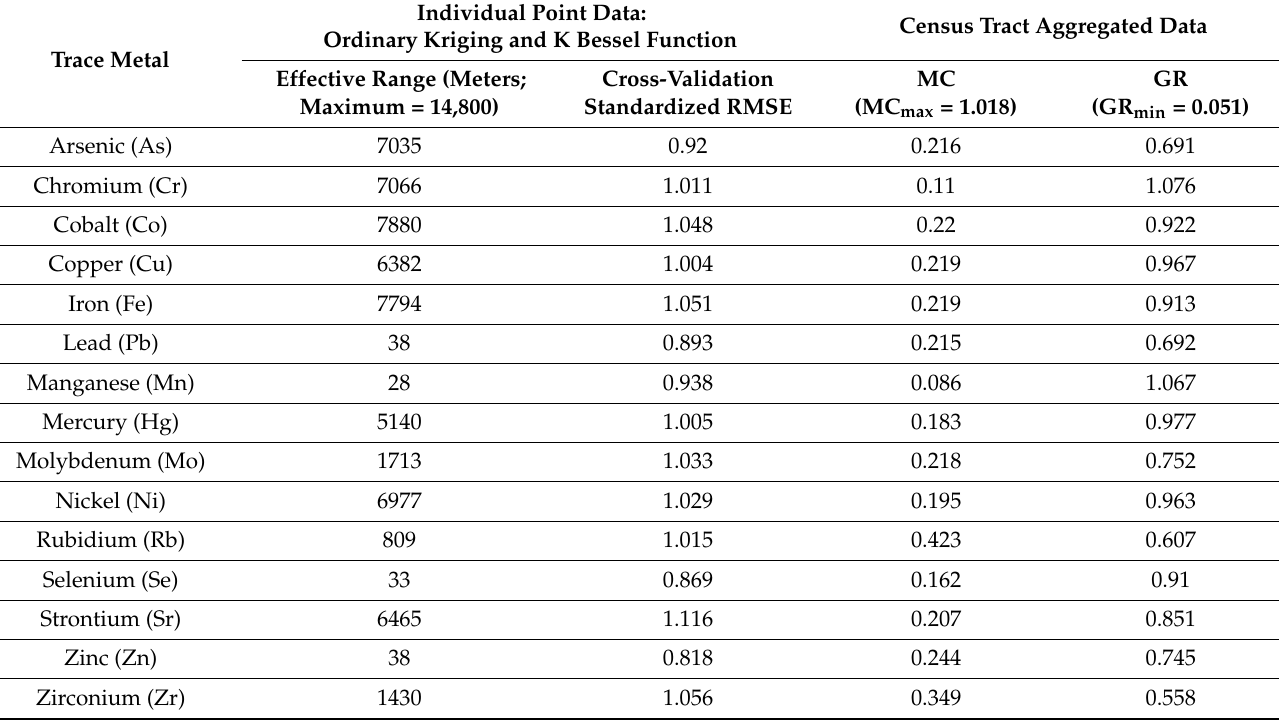
Table 3. Spatial autocorrelation index values for log-measurement errors, LN ( y + ˆ δ )